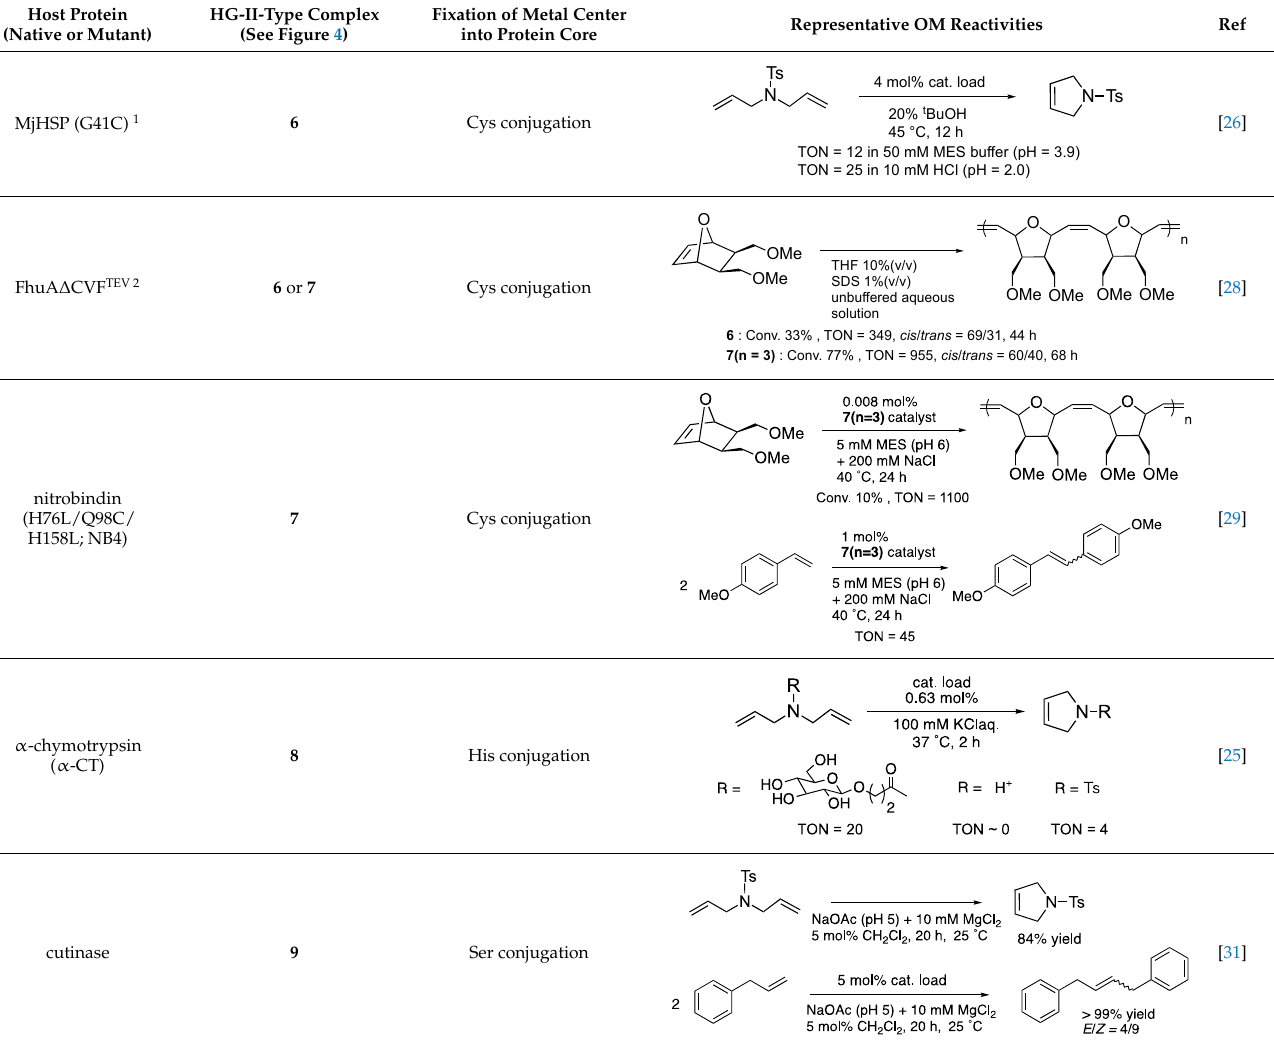
Table 1. Hybrid artificial metalloenzymes with olefin metathesis activity (OM-ArMs).